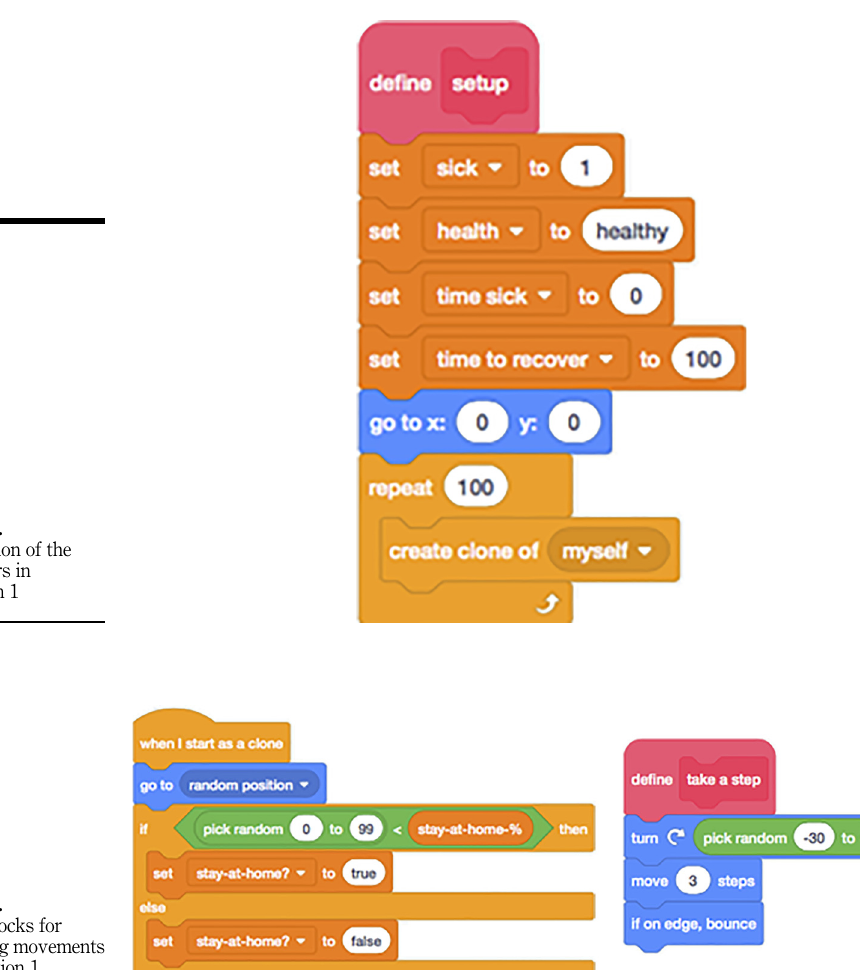
Figure 7. Coding blocks for illustrating movements in simulation